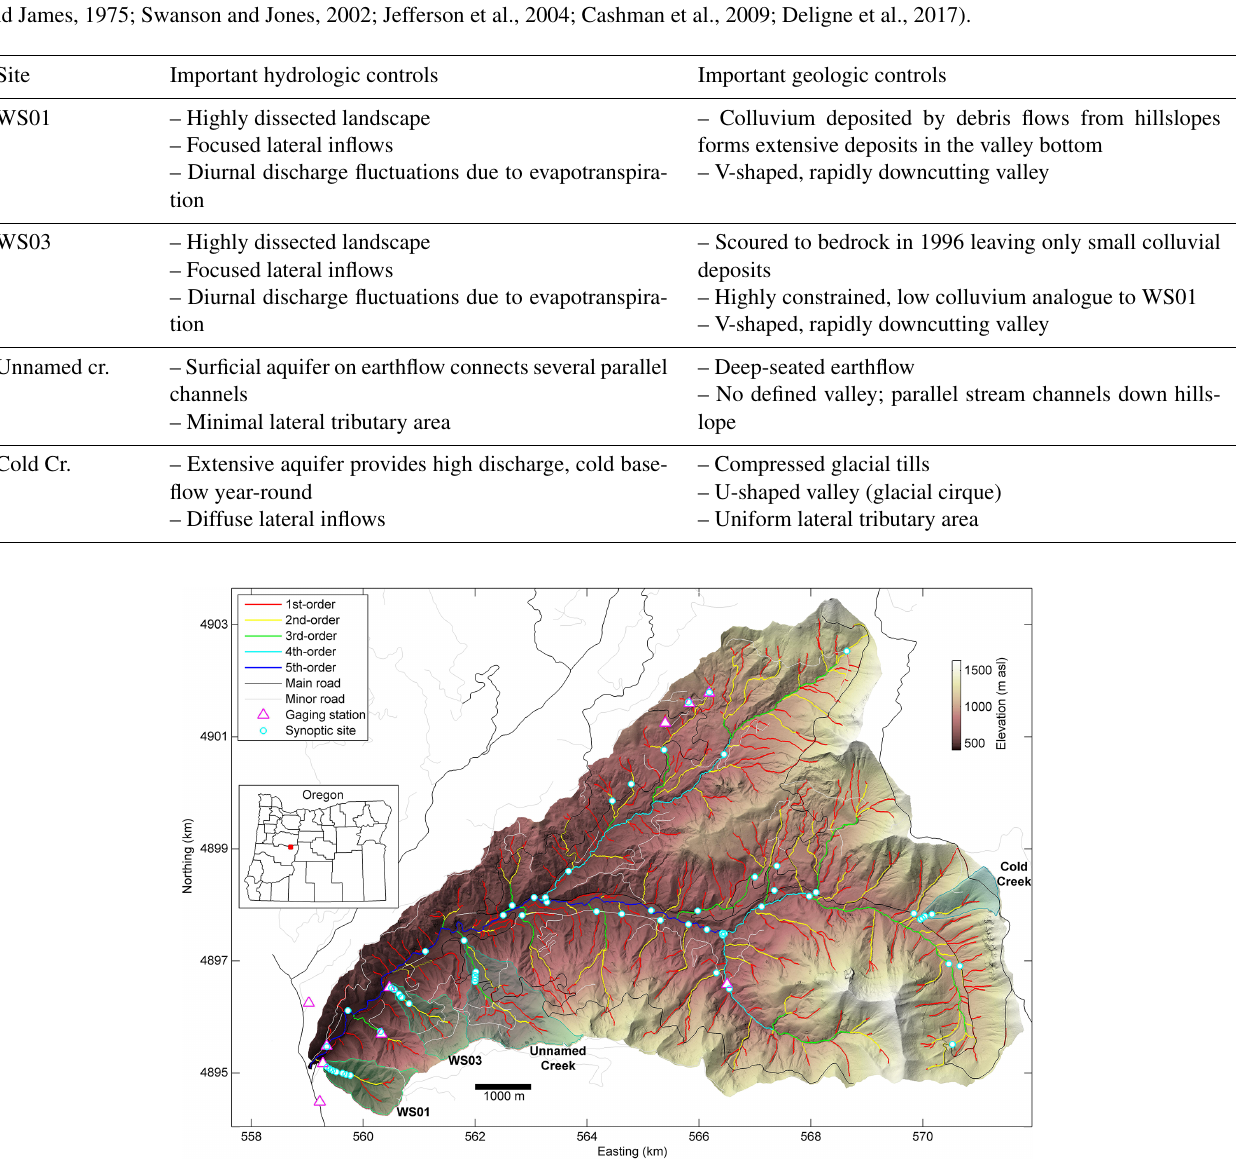
Figure 1. Synoptic study sites and lidar-derived stream network for the H. J. Andrews Experimental Forest. Reprinted with permission from Ward et al.